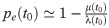
The winter is coming effect.Pathogen birth rate (i.e. transmission rate) λ(t) is assumed to vary periodically following a square wave (A and B). During a portion 1 − γ of the year transmission is maximal (γ = 0.7 in this figure) and λ(t) = λ0. In the final portion of the year λ(t) drops (low transmission season in gray). In A λ(t) varies between λ0 = 2.5 and 1.5 and, in B λ(t) varies between λ0 = 2.5 and 0. Pathogen death rate
μ(t) (a function of recovery and death rates of the infected host) is assumed to be constant and equal to 1 in this figure. When the net growth rate of the pathogen remains positive in the low transmission season (λ(t) > μ(t), A, C and E) the probability of emergence of a pathogen introduced at time t0 can be well approximated by Eq (6): pe(t0)≃1−μ(t0)λ(t0) (dashed line in E and F) if the duration of the infection is short relative to the period T of the fluctuation (E). In contrast, if the low transmission season is more severe (λ(t) < μ(t), B, D and F), the negative growth rate φ(t) of the pathogen population during this period creates a demographic trap and reduces the probability of emergence at the end of the high transmision season. This winter is coming effect is indicated with black arrow in (D) and with the light gray shading in (D) and (F). This effect is particularly pronounced when the period of the fluctuations of the environment is large relative to the duration of the infection (i.e., when T is large, F). When the period T of the fluctuation is small relative to the duration of the infection, the probability of emergence is well approximated by Eq (5): pe≃1−1R0 whatever the time of pathogen introduction (in A, R0 = 2.2 and pe ≃ 0.55; in B, R0 = 1.75 and pe ≃ 0.43).